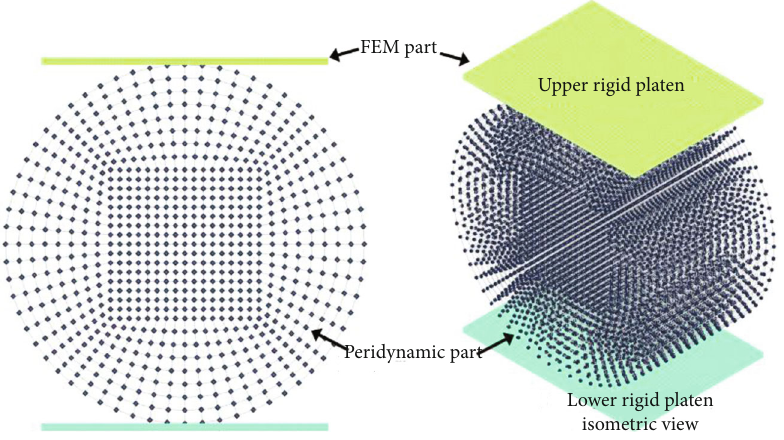
Figure 3: Microimage of marble.